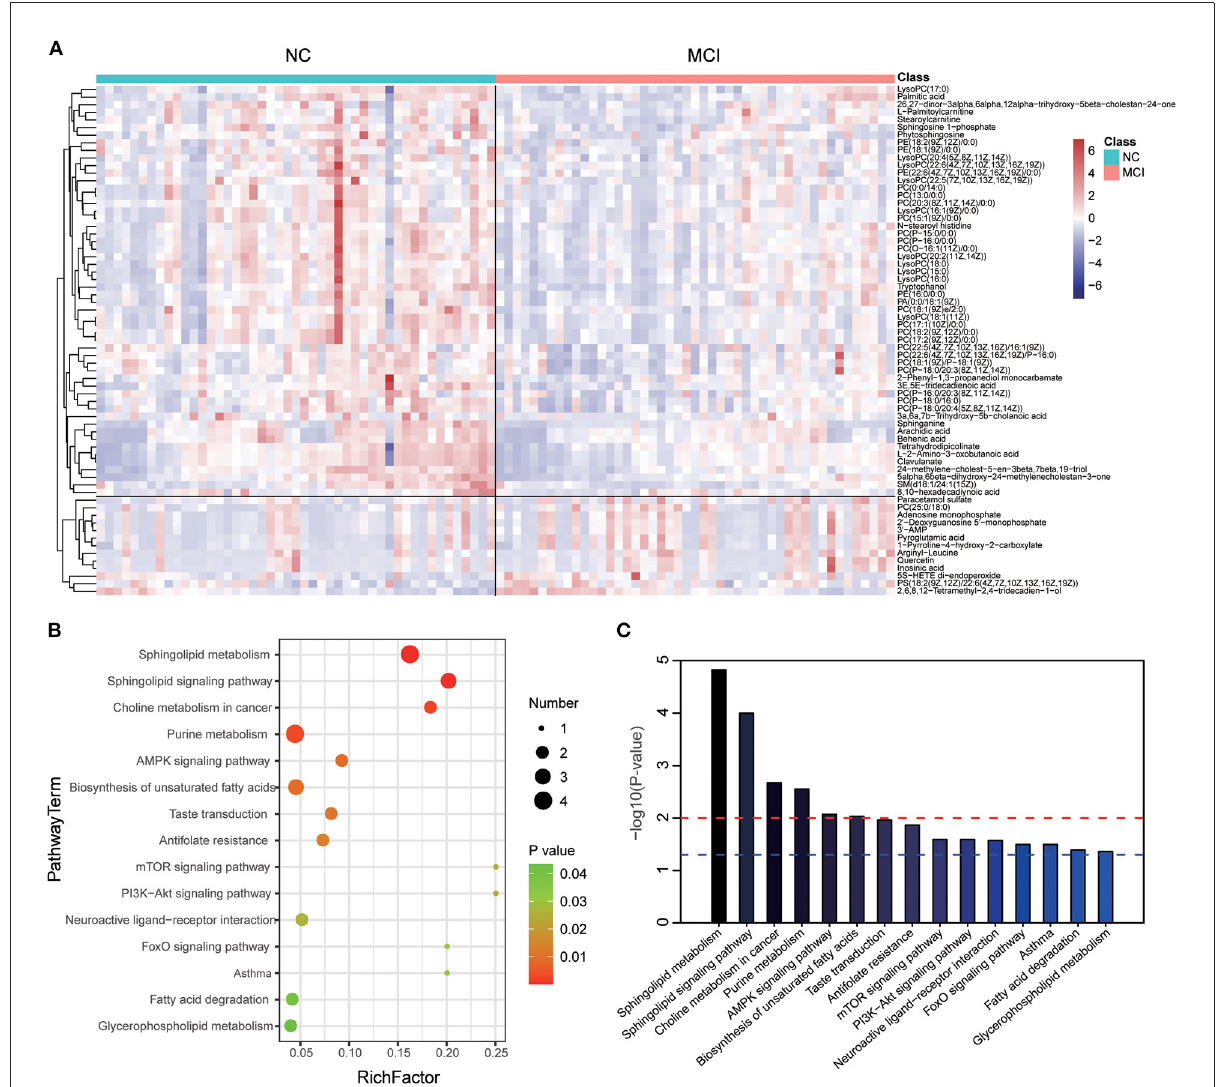
FIGURE2 Heat map and metabolic pathway analysis based on the differentiated plasma metabolites. (A) The heat map showed the important differential metabolites profiling in serum samples of the NC and MCI groups. The blue color indicates a decreased level, and the red color indicates an increased level. (B) Pathway analysis indicates sphingolipid metabolism is the most statistically enriched pathway. (C) Plasma metabolite-based metabolic pathway